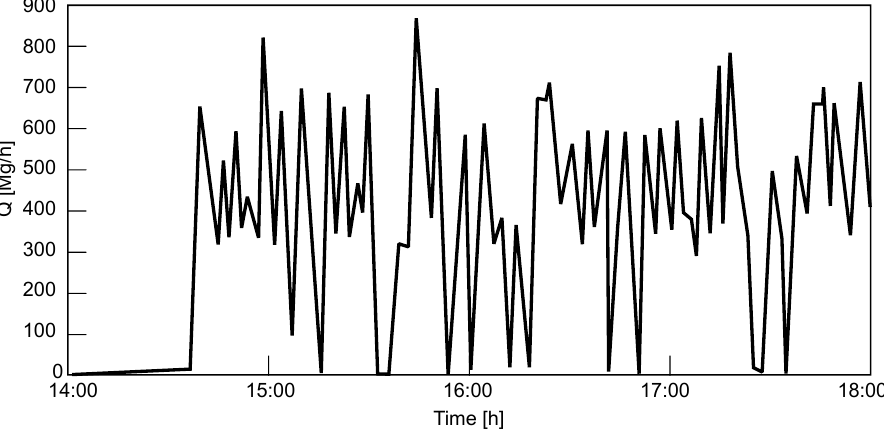
Figure 2. Capacity of the crusher feeding the WD-1 conveyor.